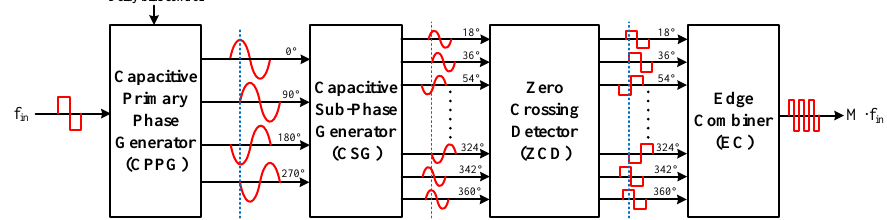
Figure 1. Architecture of FIR-filter-based clock